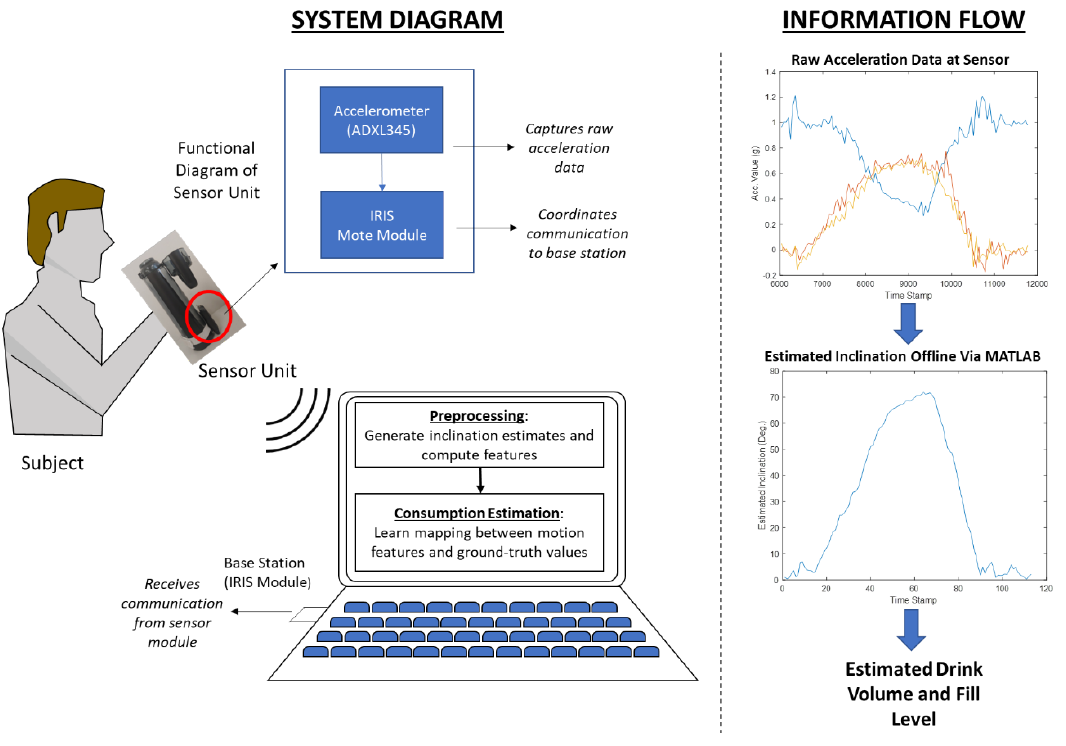
Figure 3. System and information flow diagram.